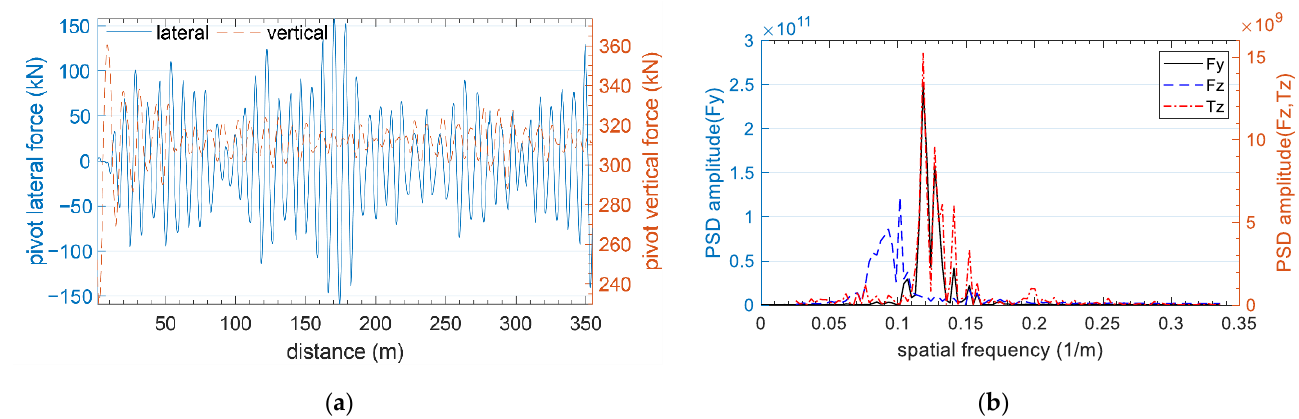
Figure 6. Lateral and longitudinal forces of interaction between the pivot and the bogie centre bowl of a loaded freight wagon 20 t/axle while riding on a straight track with irregularities, travel speed 100 km/h ( a ) Power spectral density of the interaction forces ( b ).